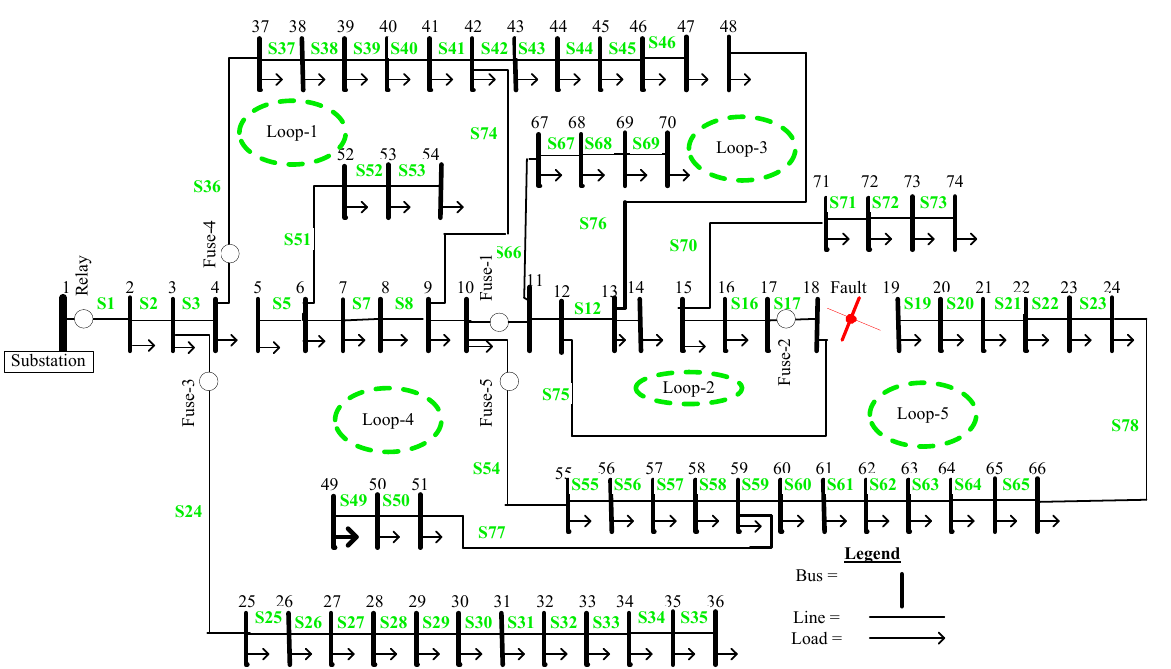
Figure 10. Restored networks in single fault cases considering protection constraints using TLBO.